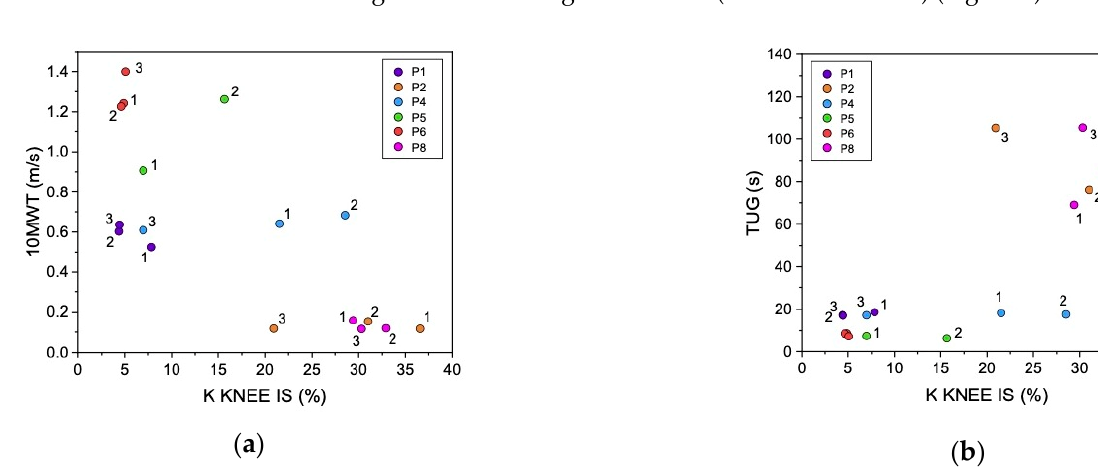
The variable selected in Section 3.3.2 was plotted for every patient and every AGS